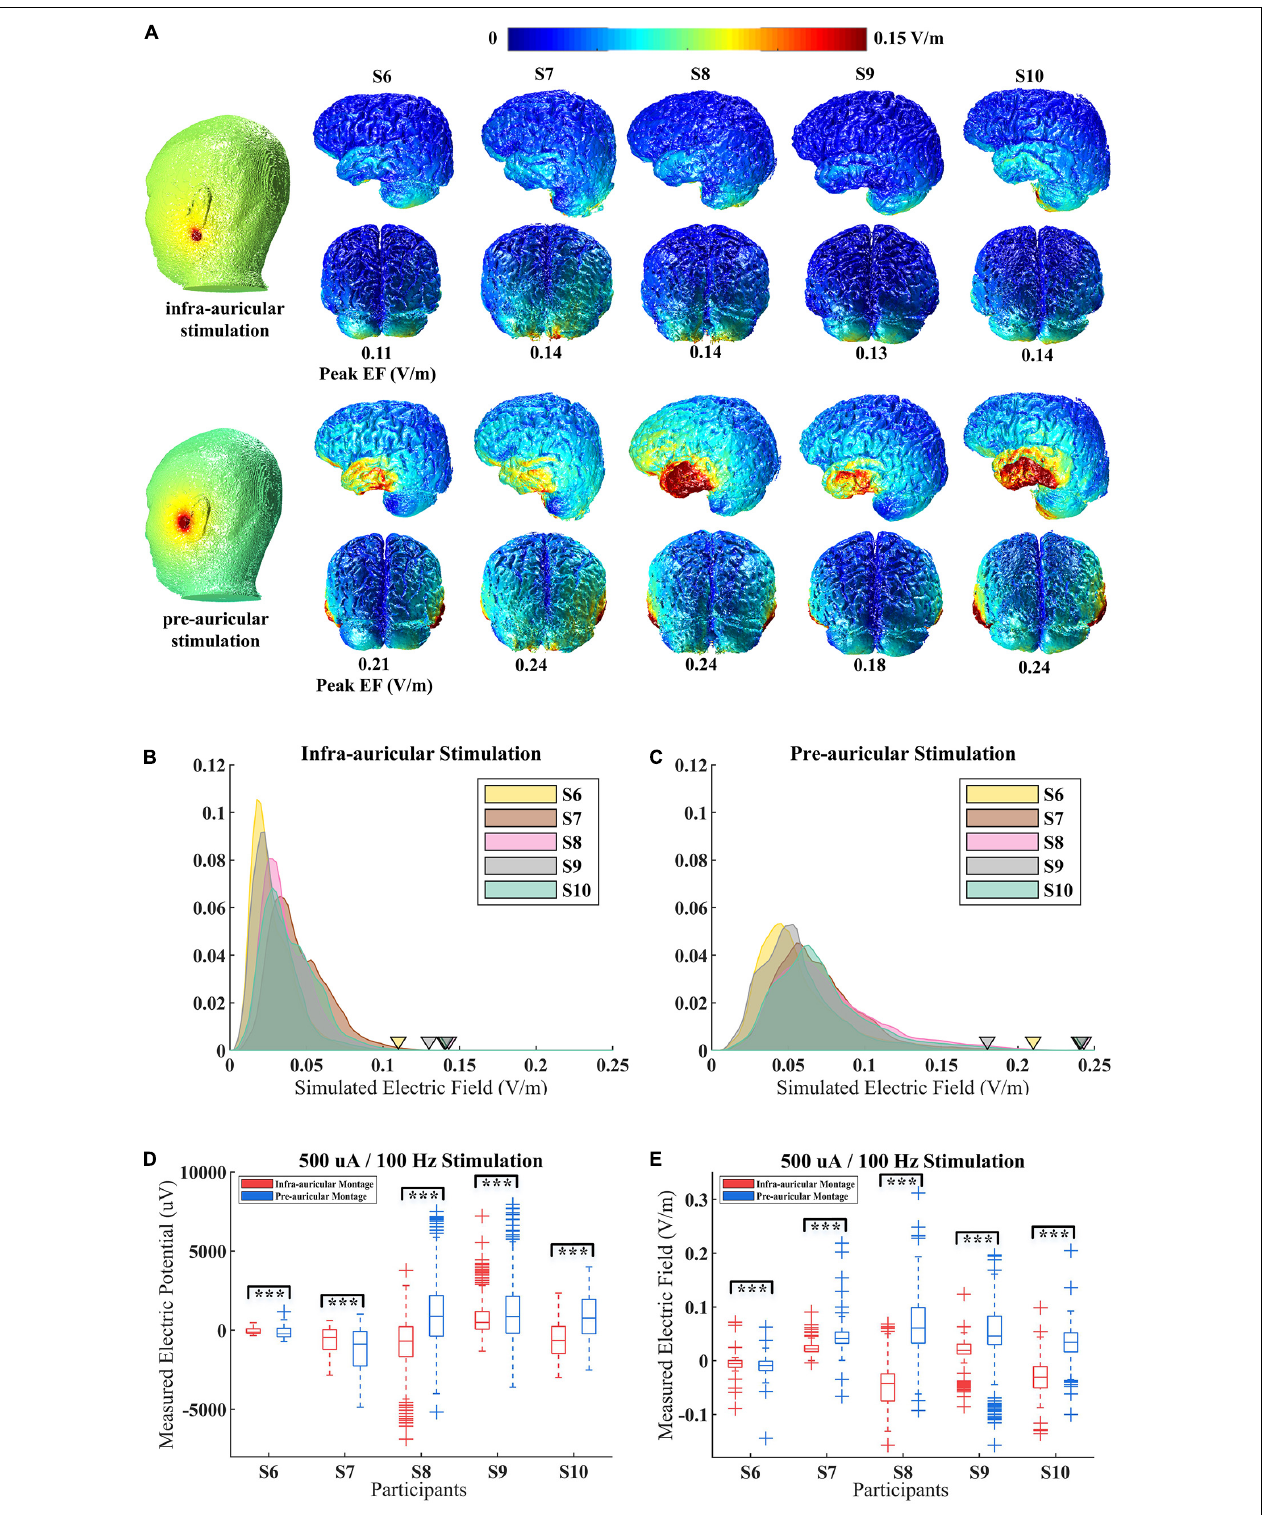
FIGURE 5 | Simulated and measured electric field (EF) distributions for different electrode montage during CES. (A) Simulated EF distributions for S6–S10 with infra-auricular and pre-auricular stimulation. (B,C) The probability density distribution of EF within brain for infra-auricular and pre-auricular stimulation. The inverted triangle represents the peak EF. (D,E) Measured voltage and projected EF distributions for S6–S10 with infra-auricular and pre-auricular stimulation. *** p < 0.01.